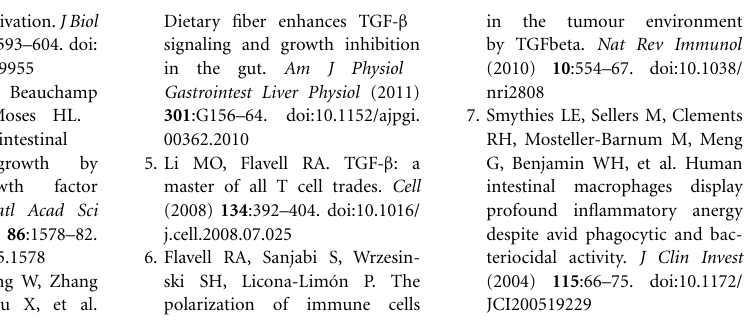
FIGURE 2 | Intestinal SCFA receptors and transporters . SCFAs are taken up by the epithelial cells by diffusion, H + coupled transport by monocarboxylate transporters (MCT) or by Na + coupled transport by SLC5A8.